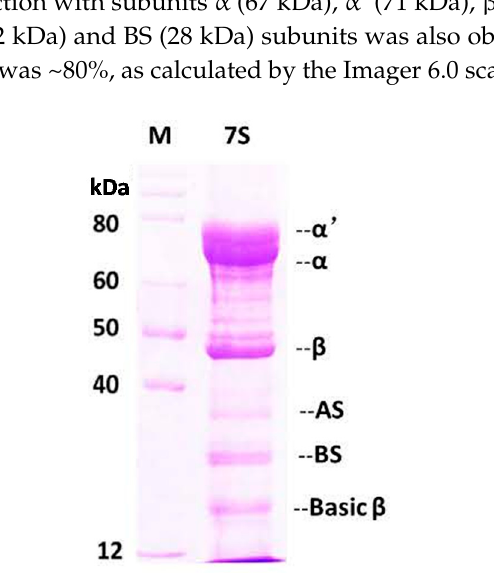
Figure 2. SDS-PAGE analysis of soy protein 7S. Conditions: 0.08 µ M soy protein 7S in 100 mM 3-(N-morpholino) propanesulphonic acid(MOPS) (5 mM NaCl), pH 7.0, 25 °C.